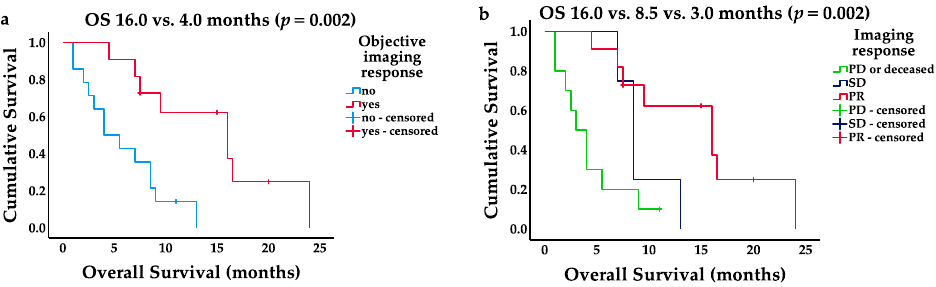
Figure 3. Kaplan–Meier survival curves. ( a ) Objective imaging response (PR) and respective OS in months; ( b ) PR, SD, and PD imaging response and respective OS in months.